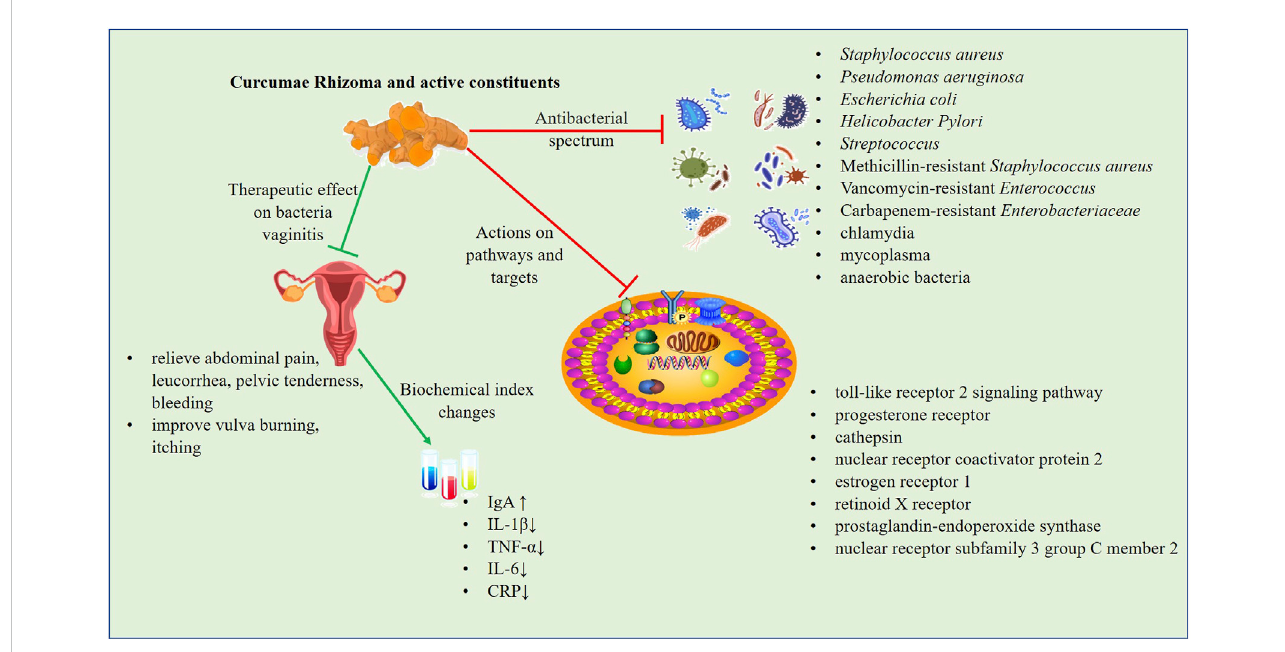
FIGURE 2 The antibacterial mechanism of Curcumae Rhizoma and its active constituents. Both Curcumae Rhizoma and its active constituents have strong antibacterialactivitiesagainstavarietyofbacteriathroughdifferentsignalingpathwaysandtargets.TheZTOvaginalsuppositoryhasde fi niteclinicalef fi cacyin the treatment of bacterial vaginitis, which can signi fi cantly decrease in fl ammatory factors (TNF- α , IL-6, and CRP), and ameliorate clinical